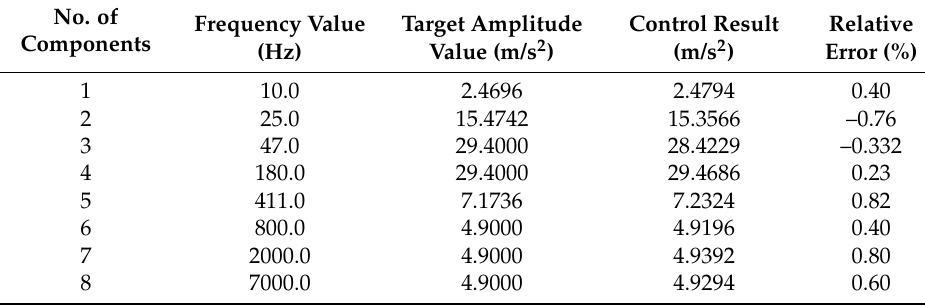
Figure 6. The spectrum and response signal curve of dwell experiment. Table 1. The control results of eight components in dwell experiment.